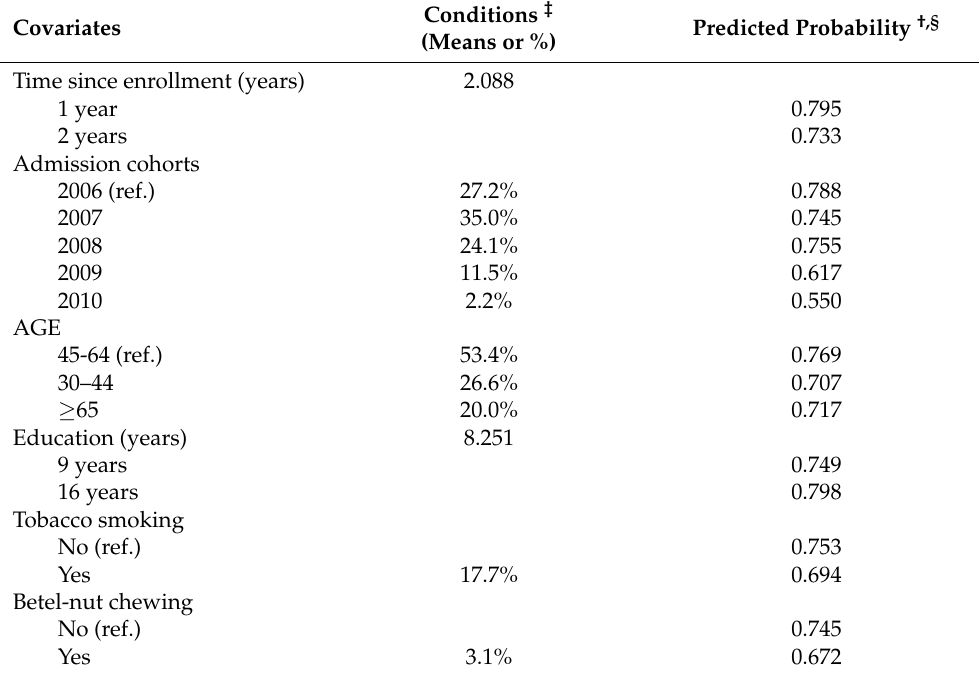
Table 4. Predicted probabilities of retention in the LIONS during